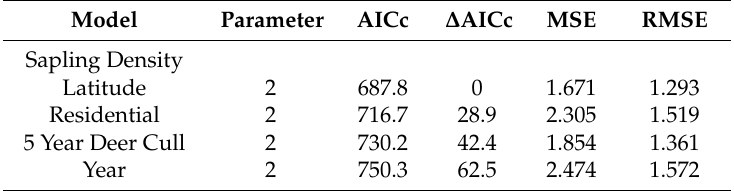
Table 2. Akaike importance weights corrected for small sample sizes (AICc) for parameters in confidence sets of linear regression models for prediction of sapling density. The difference in AICc